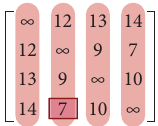
Figure 8: Discarding column 1.